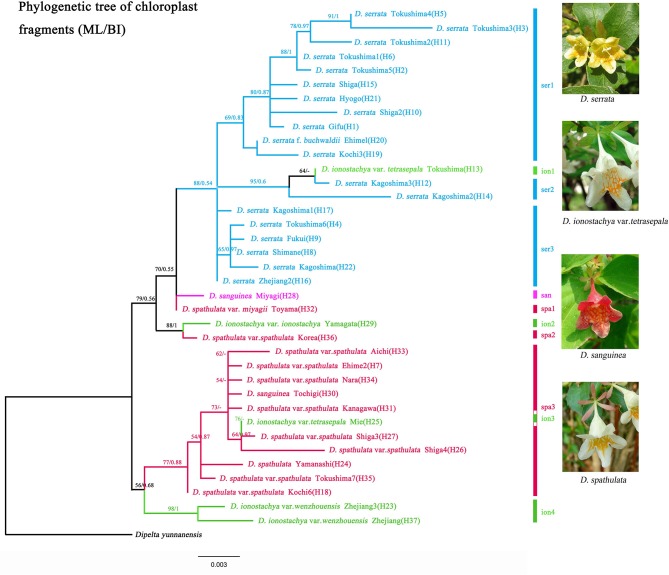
Maximum Likelihood tree inferred from RAxML for 37 haplotypes in Diabelia based on concatenated sequences of chloroplast DNA (trnH-psbA, rpl32-trnL) with Dipelta yunnanensis as the outgroup. Numbers associated with branches are ML bootstrap support values. Population migration direction inferred (a, b, and c) from haplotype phylogenetic tree of Diabelia.